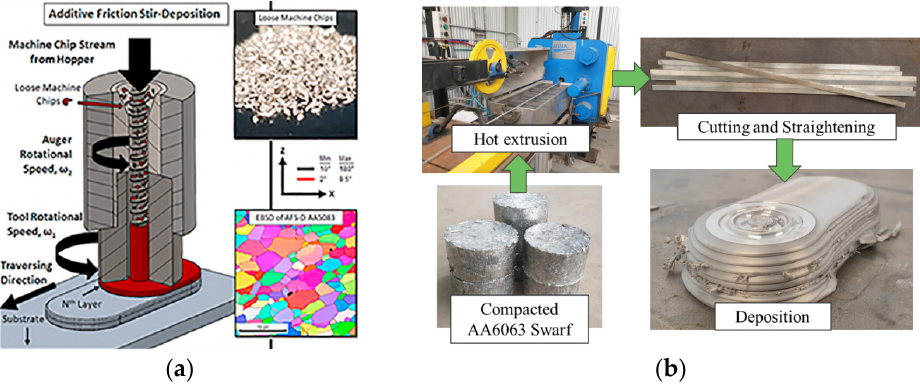
Figure 19. Different solid-state recycling processes. ( a ) Direct recycling of chips [11]. ( b ) Multi-step recycling of swarf [37].